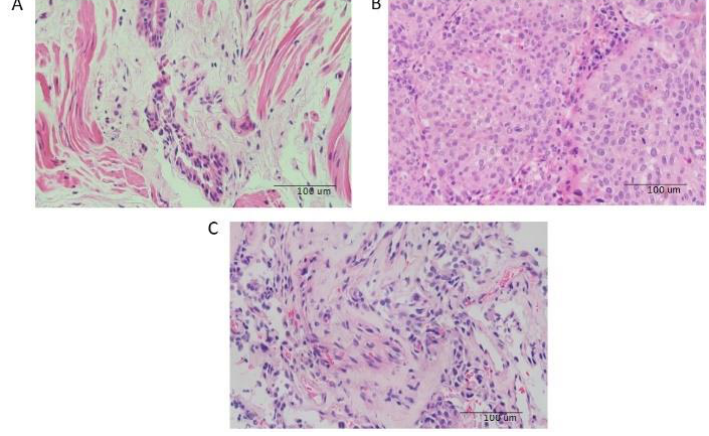
Figure 1. Images of slides with H&E staining for tissue sections from ( A ) asthmatic, ( B ) lung cancer, and ( C ) mixed cases.